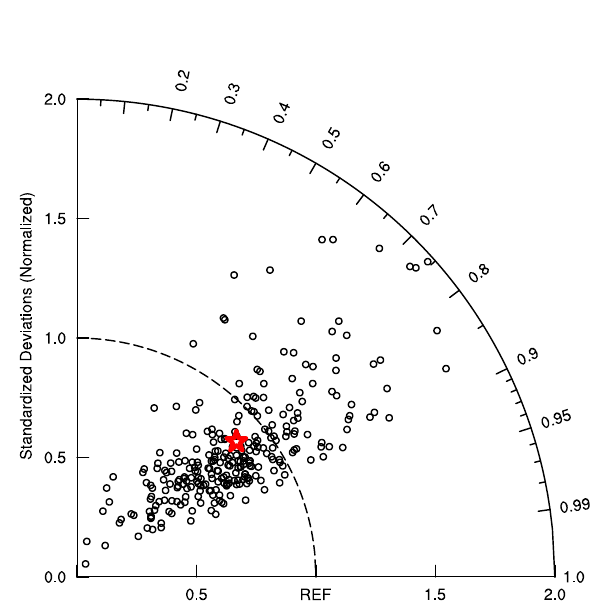
Fig. 3 Taylor diagram of the pattern correlation and normalized standard deviation for accumulated rainfall during each TC landfall from TRMM observation and PHRaMM prediction. The radial direction represents the normalized standard deviation, and the azimuthal direction represents the pattern correlation coef fi cient. The normalized standard deviation is de fi ned as the ratio of the standard deviation of precipitation simulated by the PHRaMM to that in the TRMM. Black circles represent individual TC cases and red star denotes the average value of the total 288 landfall cases, respectively.